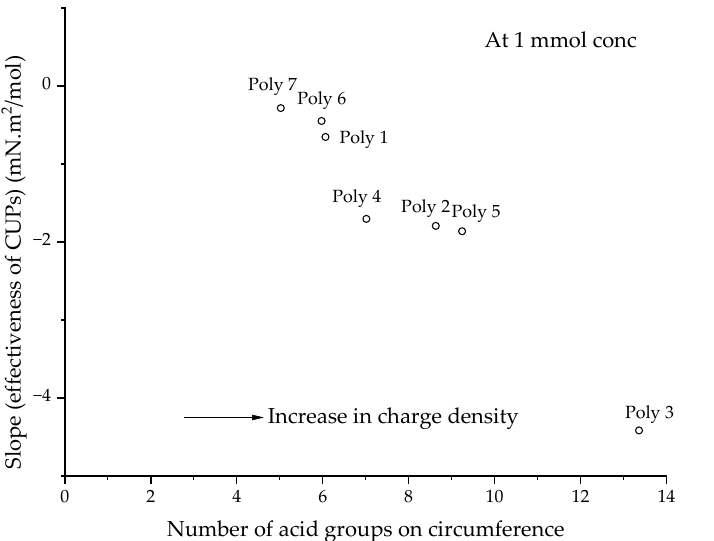
Figure 7. The slope or effectiveness of CUPs against the number of charges or acid groups present on the circumference ( N charge ).